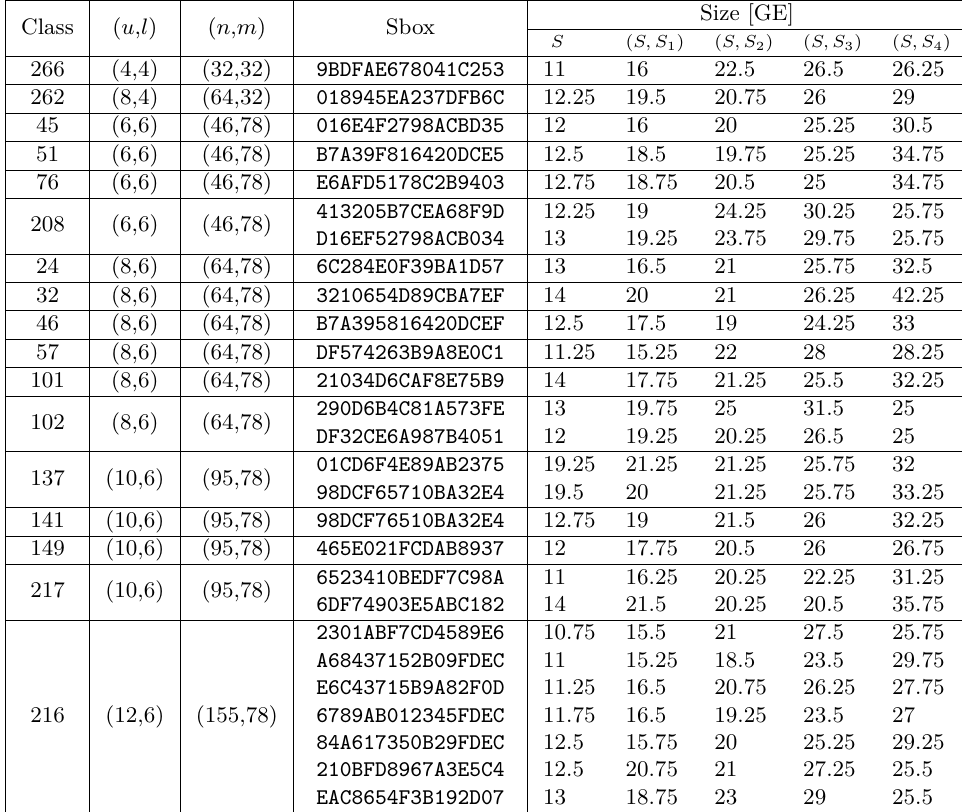
Table 3: Result of the Sbox search, area size using the IBM 130 nm ASIC